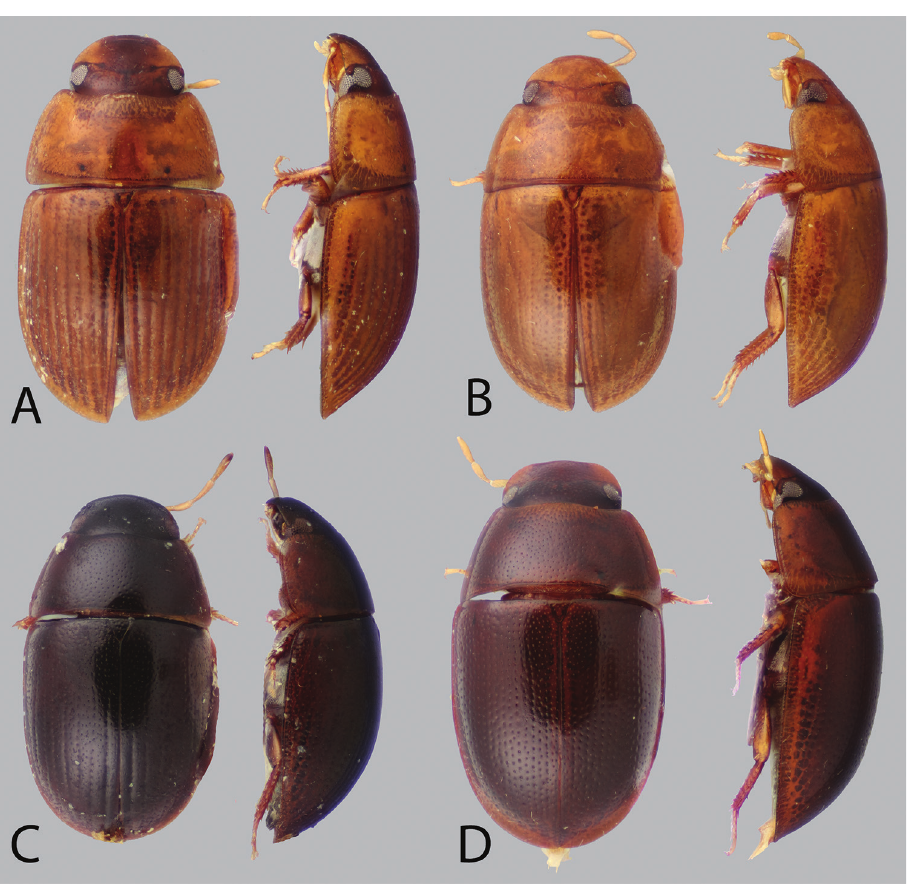
Figure 3. Dorsal and lateral habitus of Tobochares spp. A T. canaliculatus sp. n. B T. pallidus sp. n. C T. kasikasima D T. canthus sp. n. SEMC0877724/ KUNHM-ENT” (MIZA). Paratypes (23): VENEZUELA: